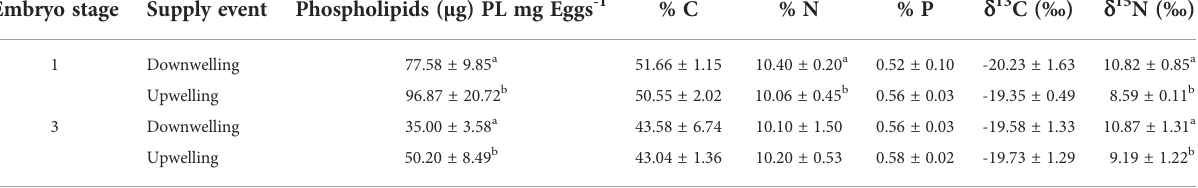
TABLE 1 Phospholipid, elemental and isotopic content (mean ± SD) of embryos collected from wild Carcinus maenas females during downwelling ( n = 10 females for stage 1 and 10 females for stage 3) and upwelling ( n = 10 females for stage 1 and 10 females for stage 3). Embryo stage